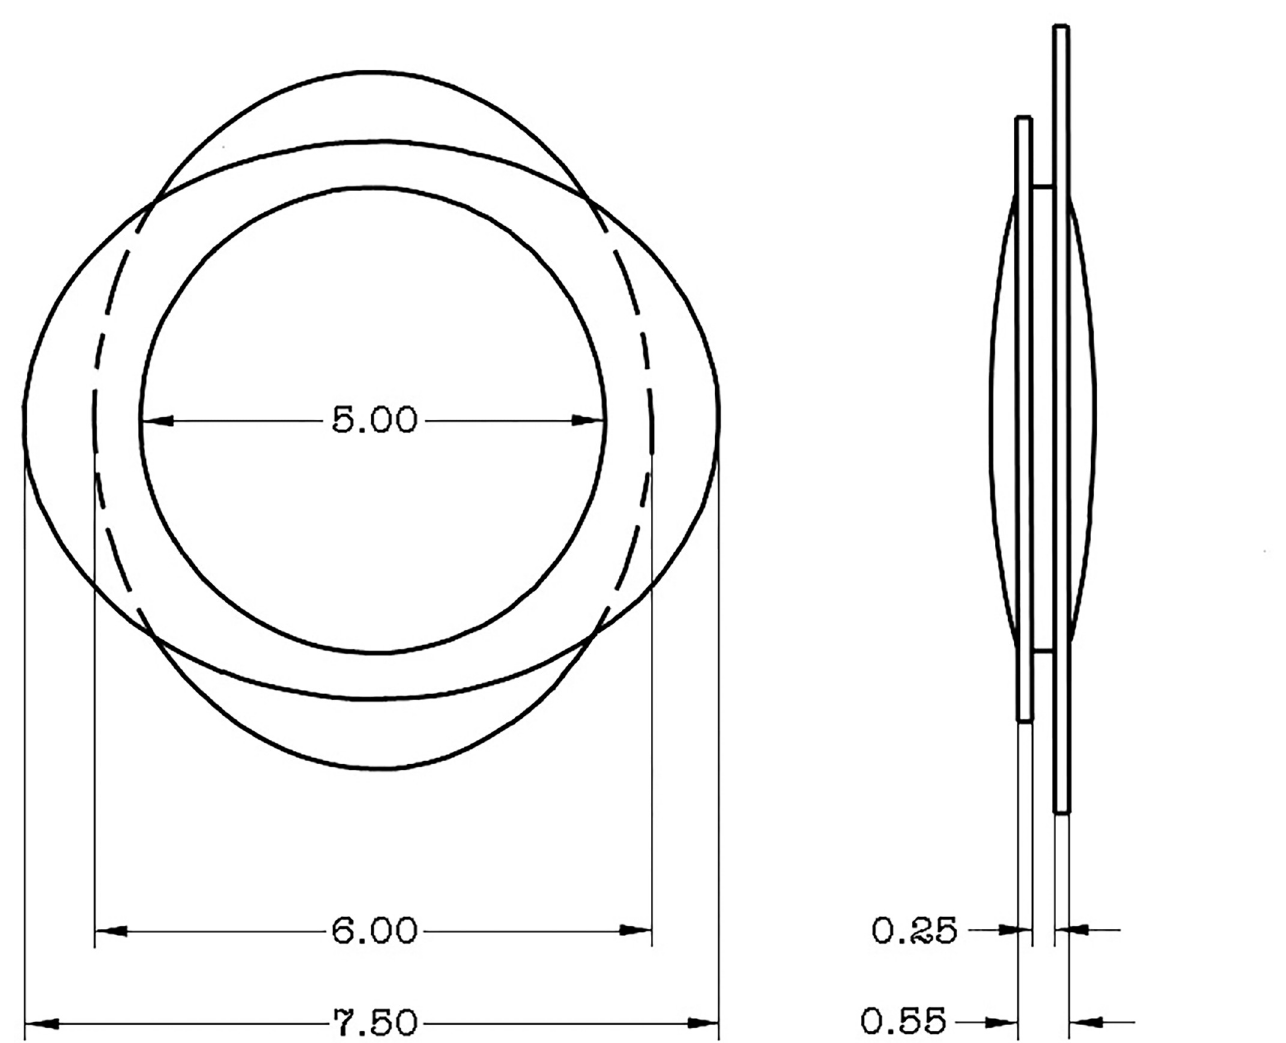
Fig 1. Technical drawing of the ‘bag-in-the-lens’ (BIL) biconvex design, Morcher 98A, as published in: US patent 6,027,531 on February the 22nd, 2000. The patents belong to the public domain since 2018. The figure was illustrated by Marie-Jose´ Tassignon.